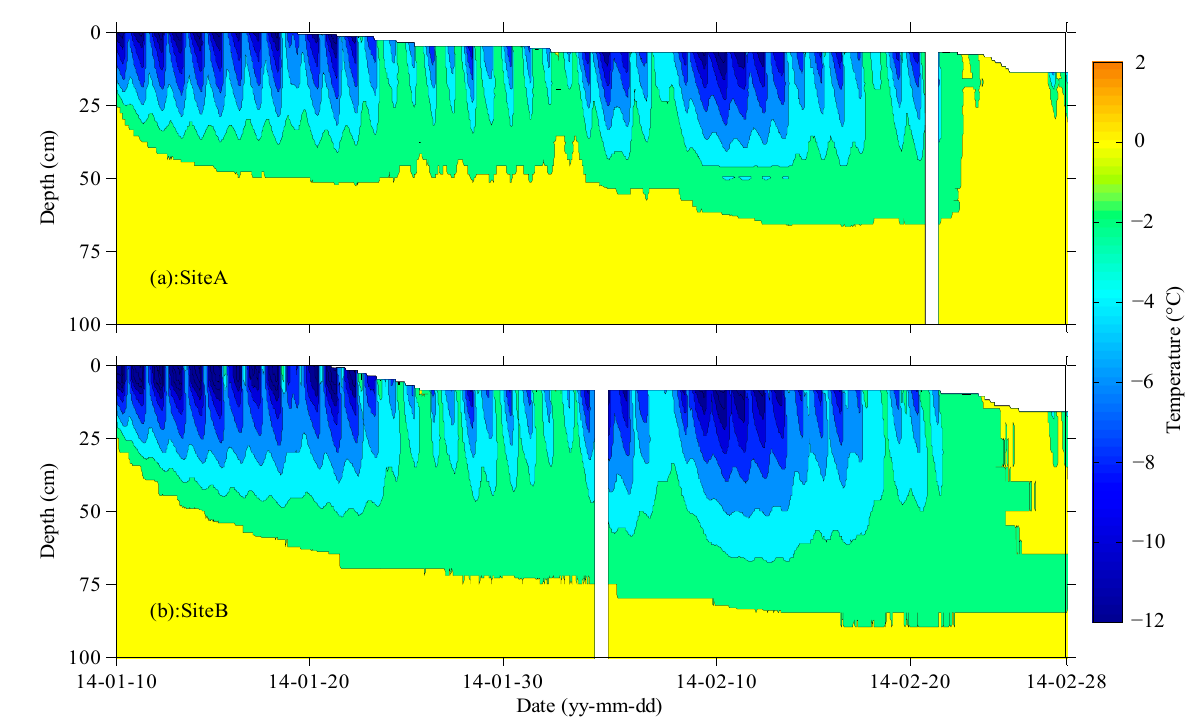
Figure 12. Internal ice and water temperature evolution at Site A ( a ) and Site B ( b ). We computed radar transmission speeds in river ice using travel times and ice thick- nesses measured at a number of locations. Results show (Figure 13) that these speeds in river ice were between 0.141 m/ns and 0.164 m/ns, lower than those observed in ‘pure’ ice. This result is consistent with previously published data; for example, Moorman and Michel [46] noted that ice melting on Bulb and Kame lakes had transmission speeds of 0.133 m/ns and 0.140 m/ns, respectively. These workers were also able to clarify that the slower velocity measured in river ice compared to ‘pure’ ice is the result of unfrozen water content. Indeed, even outside the melting period, radar transmission speeds mea- sured in natural ice are normally lower than the 0.17 m/ns that characterizes ‘pure’ ice. Hausmann and Behm [47] measured transmission speeds of cave ice between 10.157 m/ns and 0.169 m/ns, while Stoyanovich et al. [48] reported ice EM propagation velocity to be 0.154 m/ns. These data also suggest that radar transmission speeds in natural ice are highly variable; consequently, the dielectric permittivity of natural ice is not always equal to 3.17. Our results also suggest that the dielectric permittivity of ice increases in concert with ice temperature; data show that average ice temperature was − 2.85 ◦ C at Site A and − 3.32 ◦ C at Site B on 19 January 2014, during the coldest period of the whole freezing cycle. At the same time, the radar transmission speed of a pulse through river ice was 0.163 m/ns, while the equivalent dielectric permittivity was around 3.4 at Site A and Site B based on drill-hole thickness data. Data show that as spring approached, ice temperature gradually increased and was generally above − 2.00 ◦ C on 24 February 2014. Finally, after two days of rapid increases, ice temperature was close to 0 ◦ C on 27 February 2014. Equivalent dielectric permittivities also increased rapidly over this period (Figure 13), especially when the ice temperature was close to 0 ◦ C. This is because the dielectric permittivity of water is obvi- ously higher than ice, while the inevitable presence of unfrozen water within ice causes an increase in the dielectric permittivity as the temperature approaches 0 ◦ C. Previous studies that have used GPR to assess winter roads have shown that radar transmission speeds are strongly dependent on ice thickness; thus, the inherent nature of depth analysis means that the presence of unfrozen water in ice will be the main factor influencing calculations